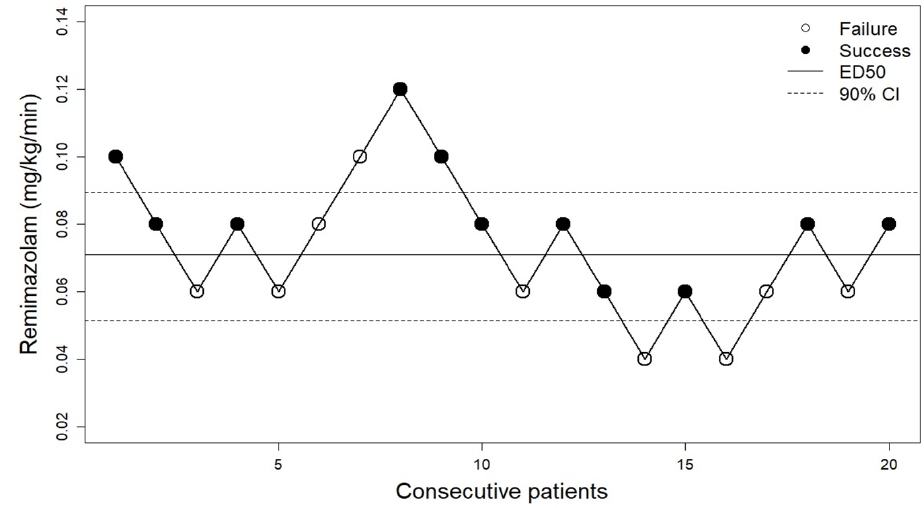
Figure 1. The up-and-down sequence of remimazolam dose for inducing loss of responsiveness within two minutes from the start of infusion. The patient sequence number ( x -axis) is the ordering of patient exposures. Success: loss of responsiveness within 2 min from the start of remimazolam infusion. Failure: no loss of responsiveness within 2 min from the start of remimazolam infusion. ED50, 50% effective dose; CI, confidence interval.